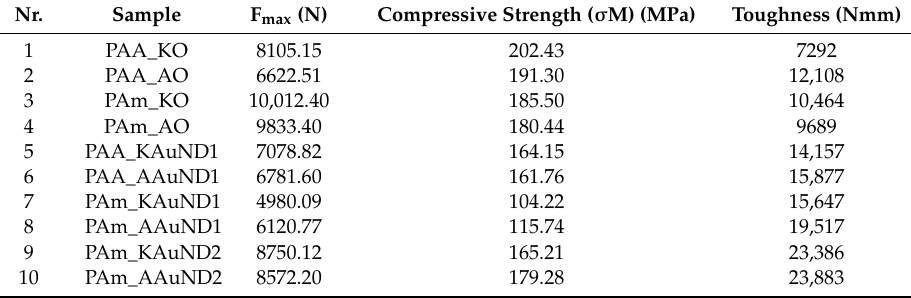
Table 4. Mechanical properties of control samples and polyacrylate-AuNPs’ composites. Nr.